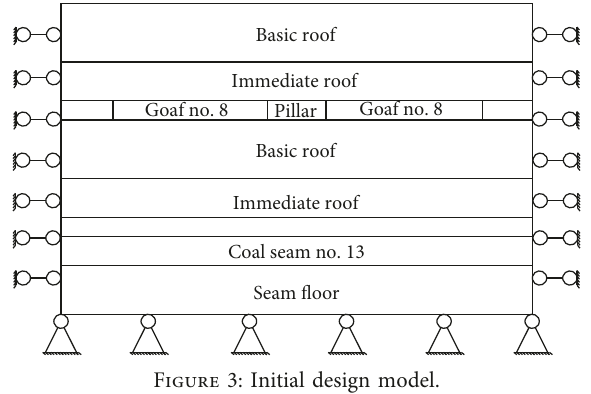
Figure 3: Initial design